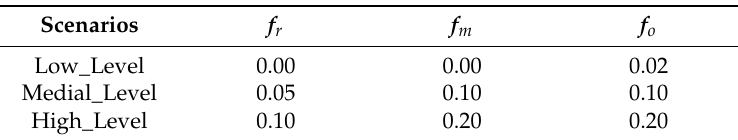
Table 2. Uncertainty prescription for the factors of standard deviations for rainfall ( f r ), and modelled ( f m ) and observed runoff ( f o